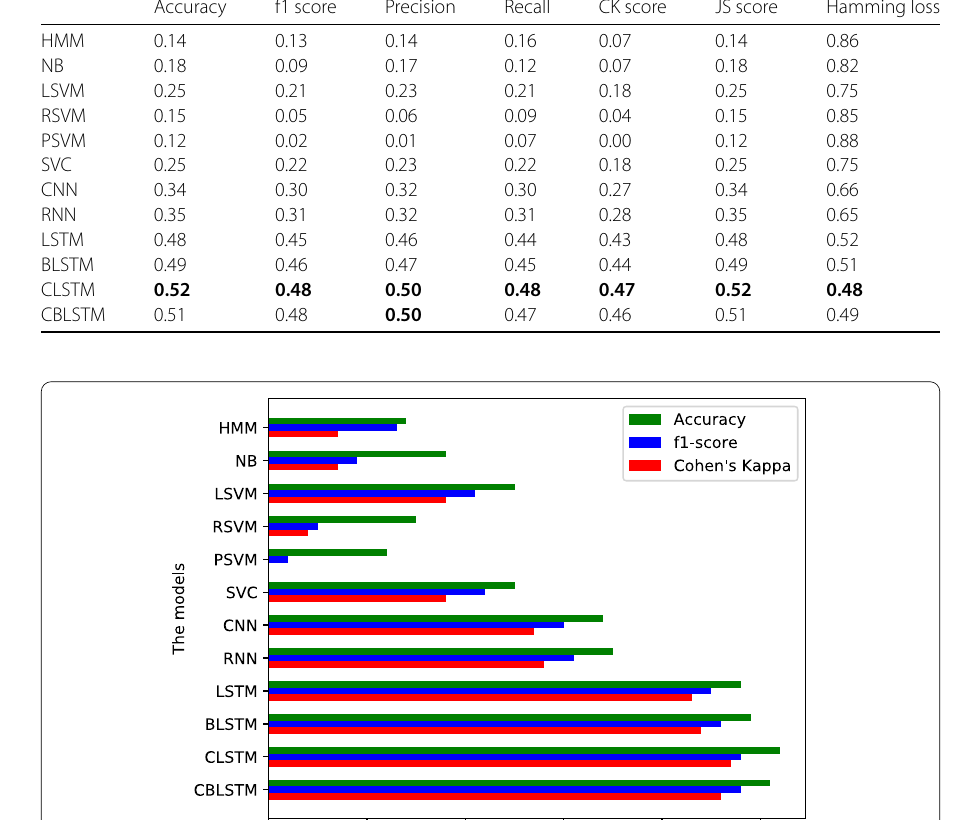
Table 6 Performance measures averaged over all trajectories of all users in a CV5 experiment. For all measures, except the Hamming loss, higher is better. CK is for Cohen’s Kappa score; JS is for Jaccard similarity